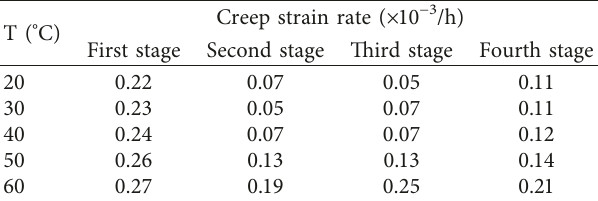
Table 4: Creep strain rate of each stage at different